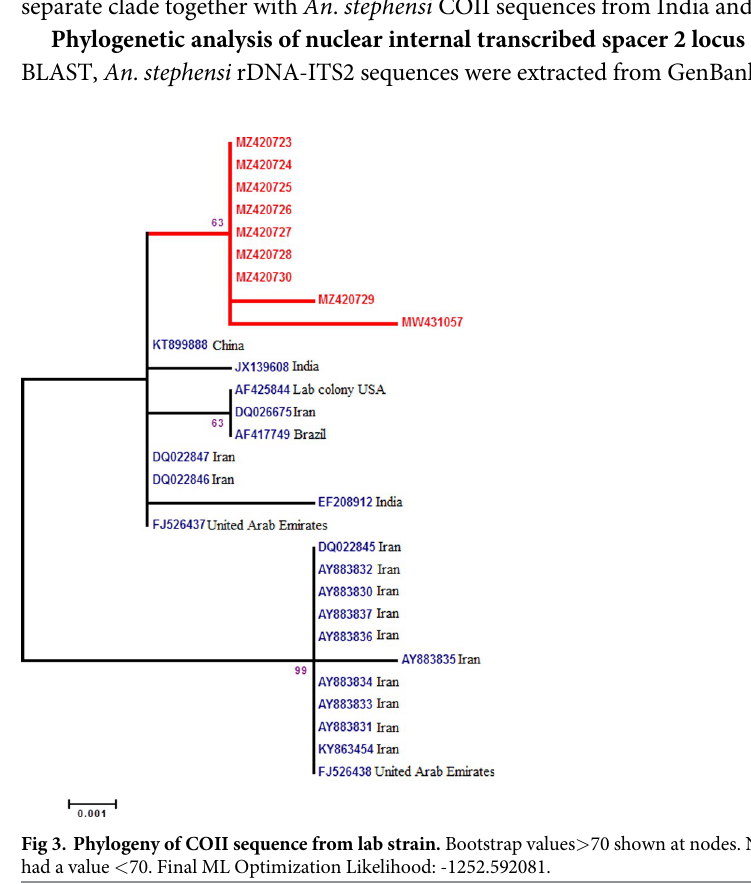
Fig 3. Phylogeny of COII sequence from lab strain. Bootstrap values > 70 shown at nodes. Nodes without numbers had a value < 70. Final ML Optimization Likelihood: -1252.592081.